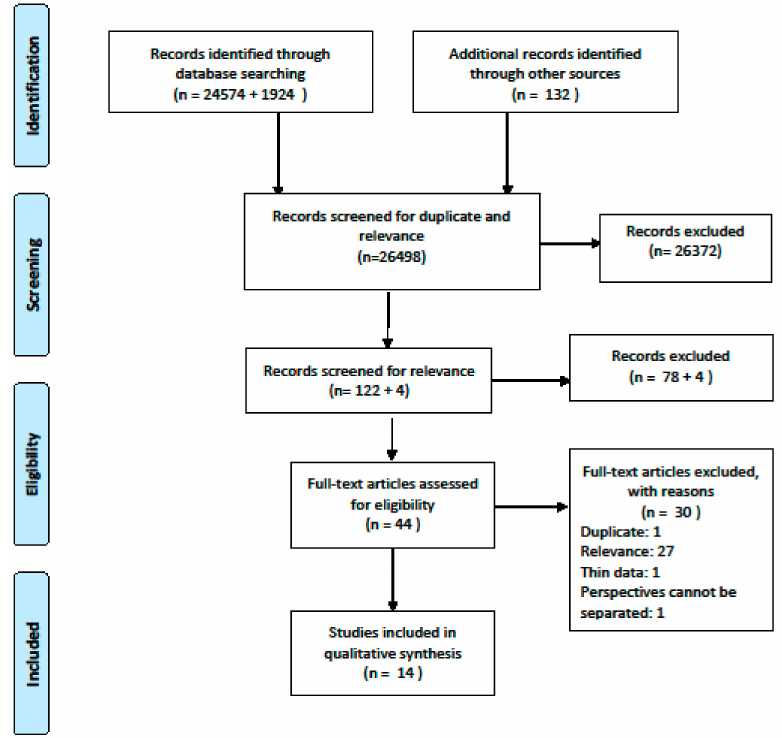
Figure 1. PRISMA Flow